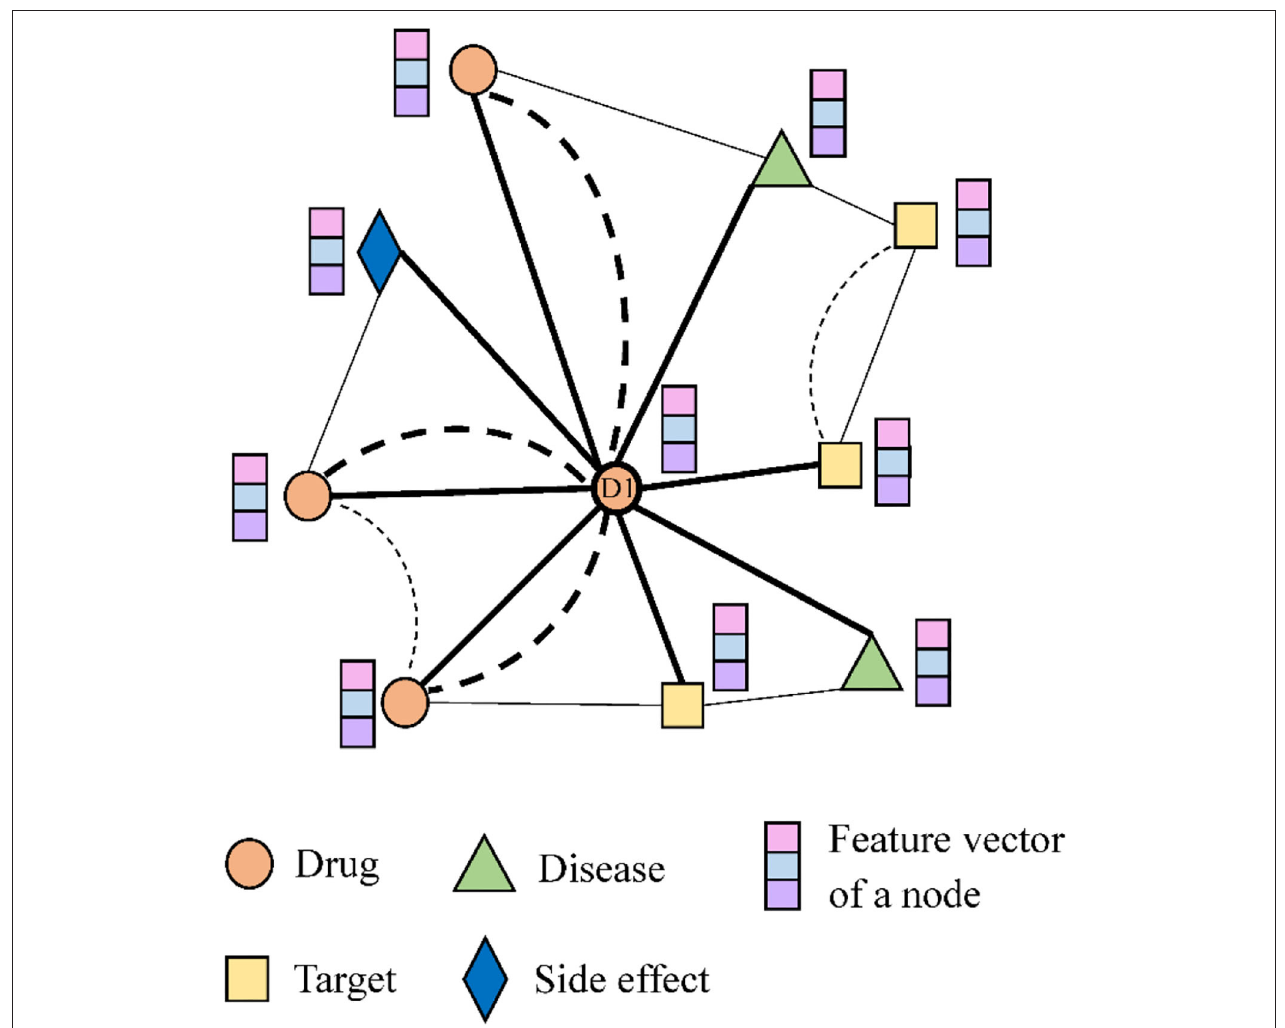
FIGURE 2 | An small example of the heterogeneous